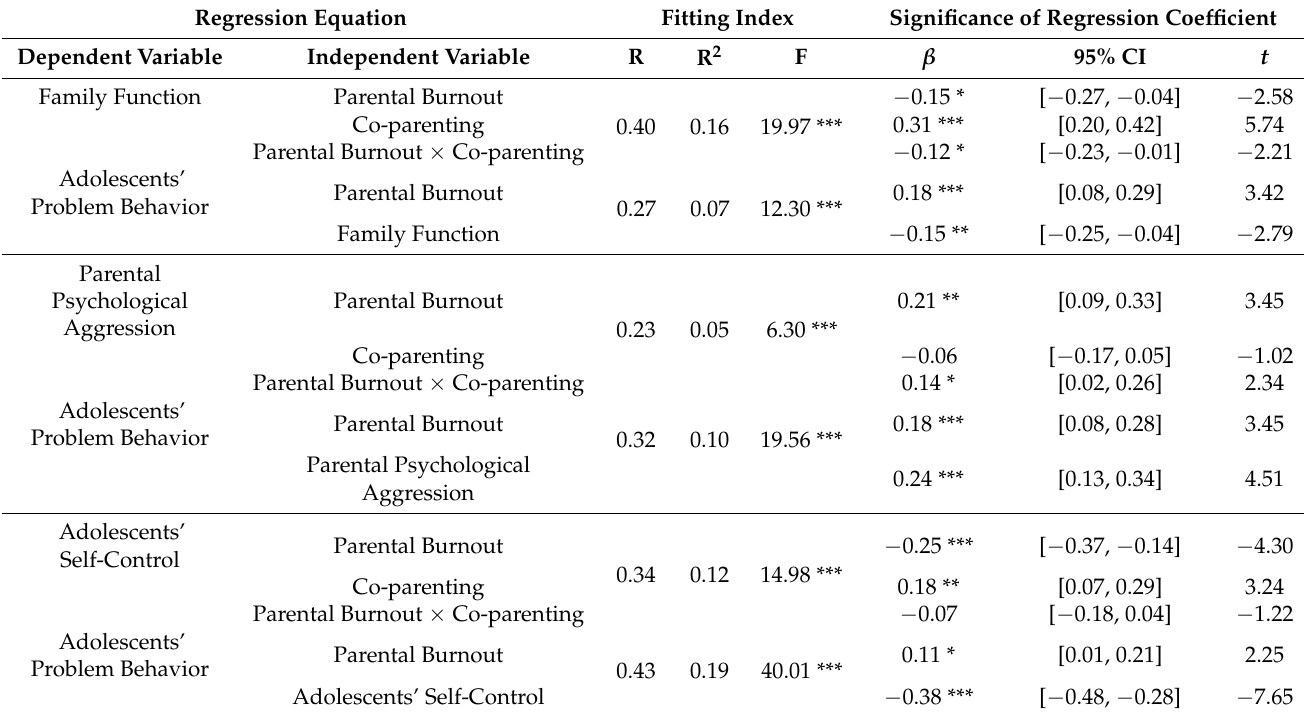
Table 2. Testing the moderated mediation effects of parental burnout on problem behavior.